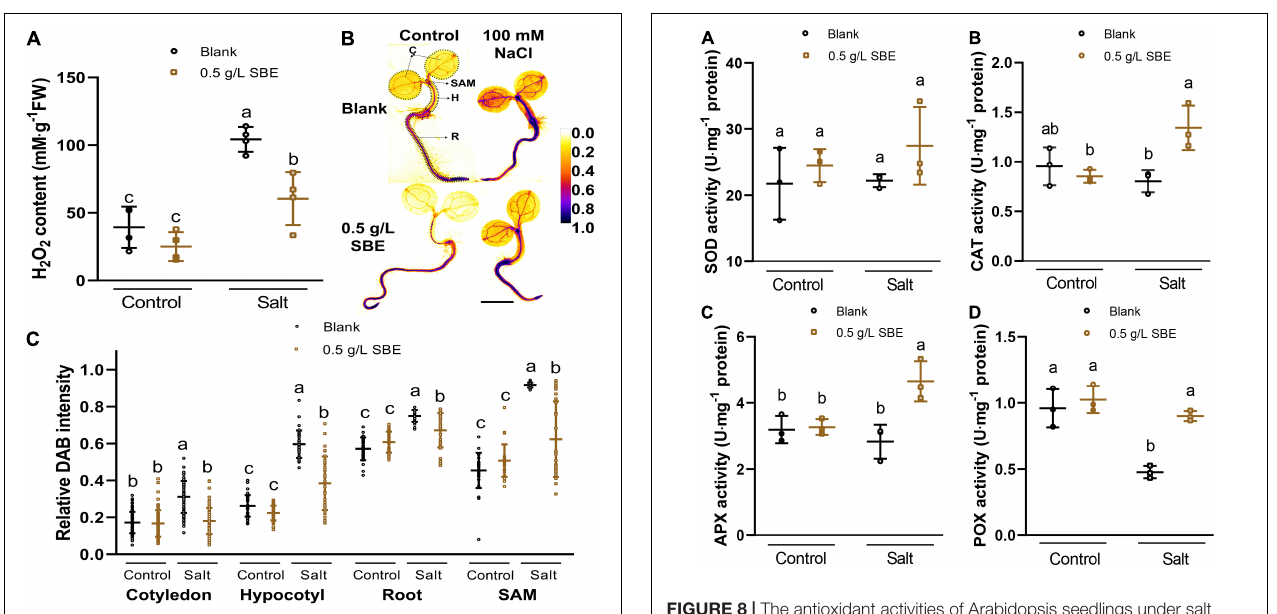
FIGURE 7 | Hydrogen peroxide accumulation of 3 DAG and 10 DAG Arabidopsis seedlings under salt stress in the true leaf assay. (A) H 2 O 2 content in 10 DAG seedlings. (B) Representative images of 3 DAG seedlings after histological staining of H 2 O 2 by DAB are shown in pseudo-colors of relative DAB intensity as shown in the color bar. Regions of interested organs are shown in circles with black dotted lines. Bar = 1 mm. (C) Relative DAB staining intensity of four organs in 3 DAG seedlings. Error bars indicate SDs of the means [ n = 4 (A) and > 25 (B) ]. Different letters represent significant differences between treatments ( p < 0.05). SBE, sunflower bark extract; DAG, days after germination; H 2 O 2 , hydrogen peroxide; DAB, 3 (cid:48) ,3-diaminobenzidine; C, cotyledon; H, hypocotyl; R, root; SAM, shoot apical meristem.